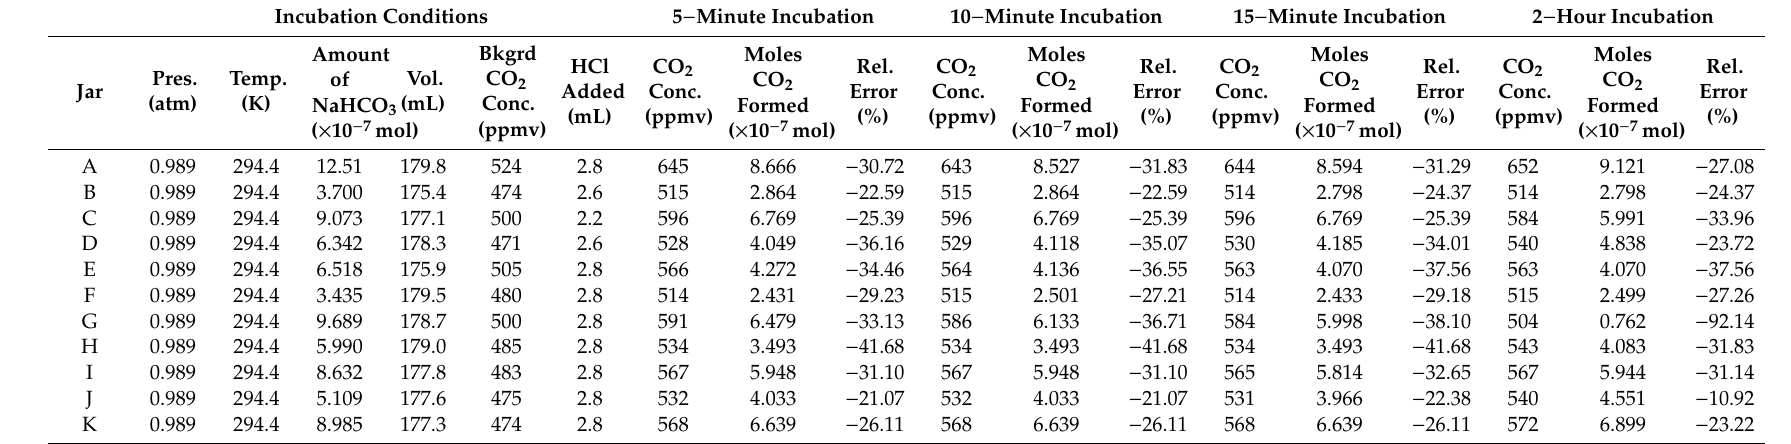
Table 1. Experiments performed on eleven containers to determine those that were most suitable for CO 2 pressure